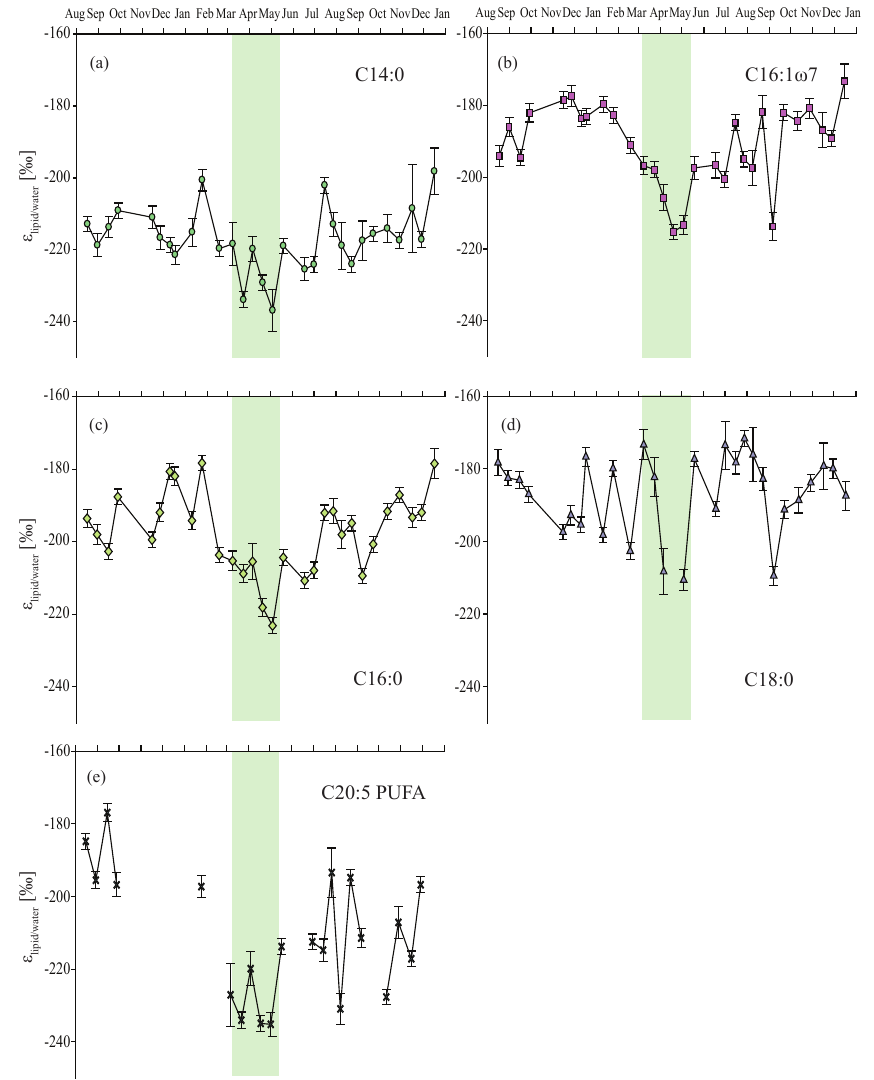
Figure 5. The D / H fractionation between fatty acids and North Sea water for fatty acids derived from suspended particulate matter in North Sea water samples. Plotted are the ε lipid/water values of n C14:0, n C16:1, n C16:0, n C18:0 fatty acids and n C20:5